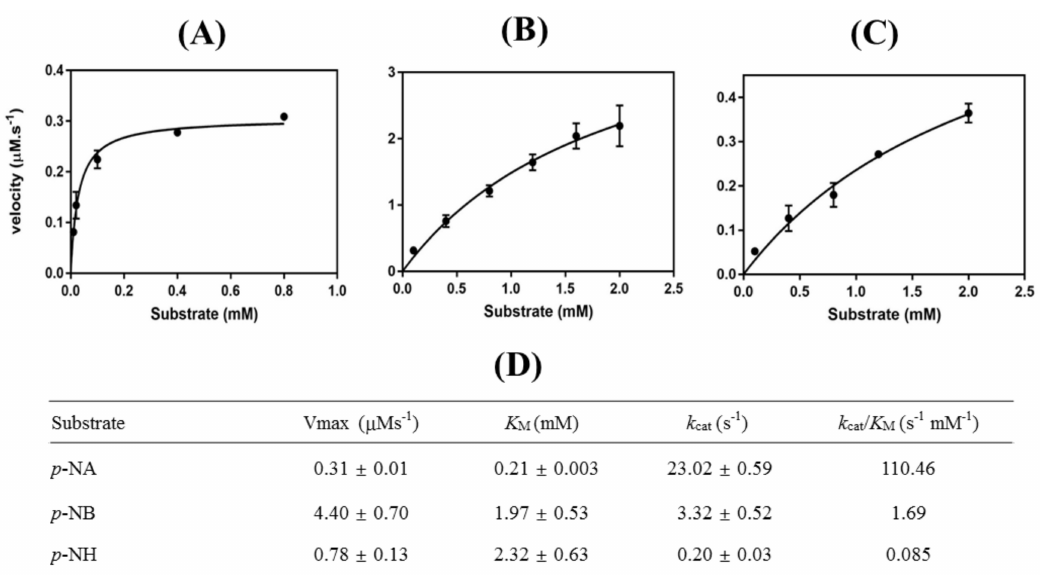
Figure 5. Kinetic analysis of Ha HSL. With di ff erent substrates of ( A ) p -NA, ( B ) p -NB, and ( C) p -NH. Kinetic parameters of Ha HSL ( D) were determined from Lineweaver–Burk plots [27]. All experiments were performed at least in